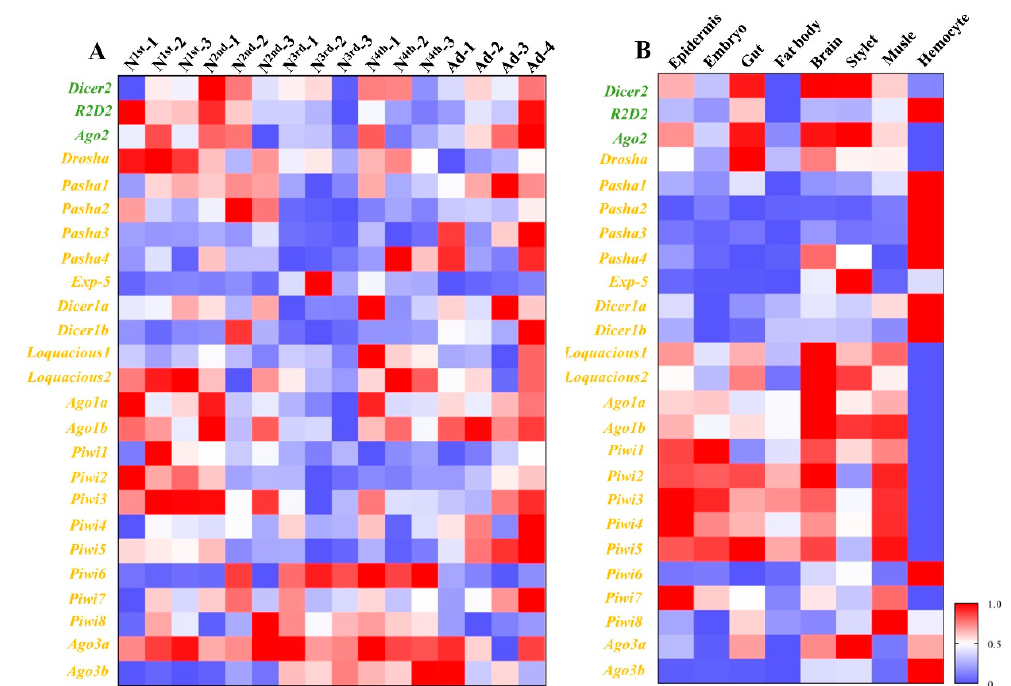
Figure 2. Spatiotemporal expression profiles of core genes of three RNA interference (RNAi) pathways in different developmental stages and different tissues. ( A ) Expression profiles of core genes of three RNAi pathways among different developmental stages. ( B ) Expression profiles of core genes of three RNAi pathways among different tissues. Mean (±SE) expression level was based on four biological replicates. The relative expression was normalized based on two reference genes, A. pisum elongation factor-1 alpha ( EF1a ) and ribosomal protein S2-like ( RPS2 ). All values are homogenized using the minimum maximum method. The green letters, orange letters, and purple letters respectively represent the genes in siRNA pathway, miRNA pathway, and piRNA pathway.